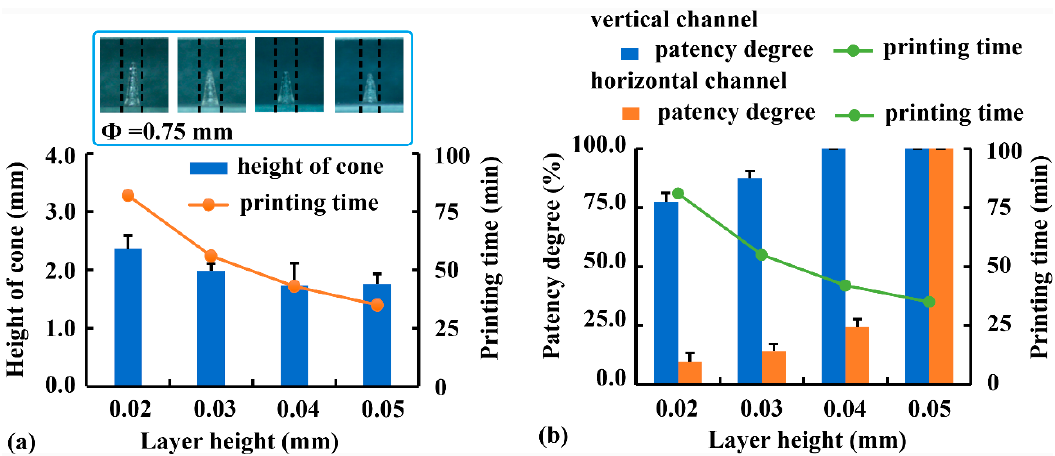
Figure 7. E ff ect of layer height on the printing accuracy and e ffi ciency of ( a ) convex cones and ( b ) Figure 7. Effect of layer height on the printing accuracy and efficiency of ( a ) convex cones and ( b ) internal channels. internal channels.